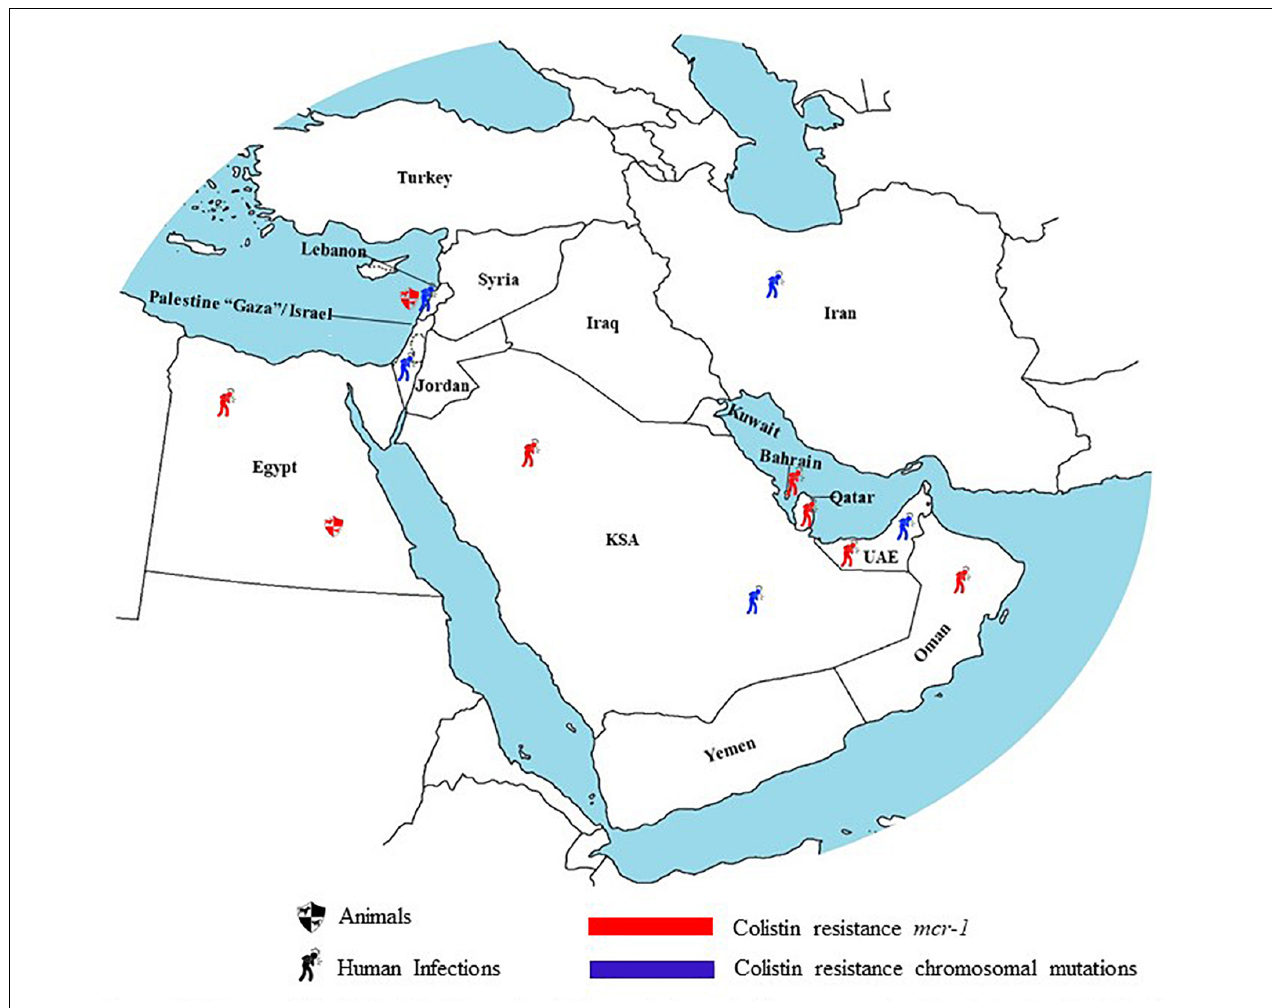
FIGURE 3 | Geographical distribution of colistin resistance in humans and animals in the Middle